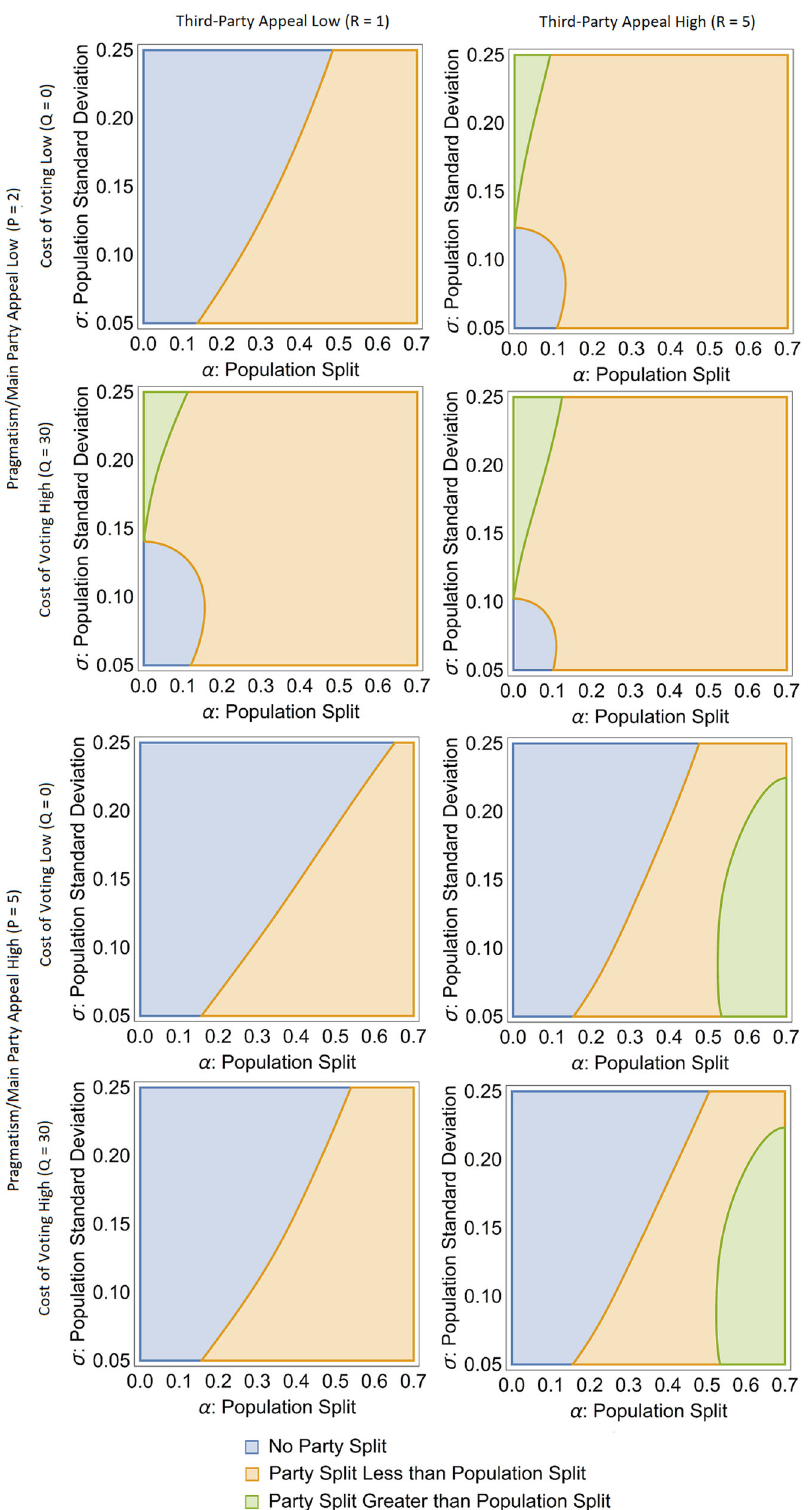
Fig. 8 The positioning of political parties relative to ideological population centers for different parameters of the voter choice model ( P , Q , R ) and different population ideological distributions ( σ , α ). P takes values of 2 (rows 1 and 2) and 5 (rows 3 and 4), Q takes values of 0 (rows 1 and 3) and 30 (rows 2 and 4), and R takes values of 1 (left column) and 5 (right column). P and R seem to have the most impact on optimal candidate behavior, with Q only changing behavior when P and R are both small.